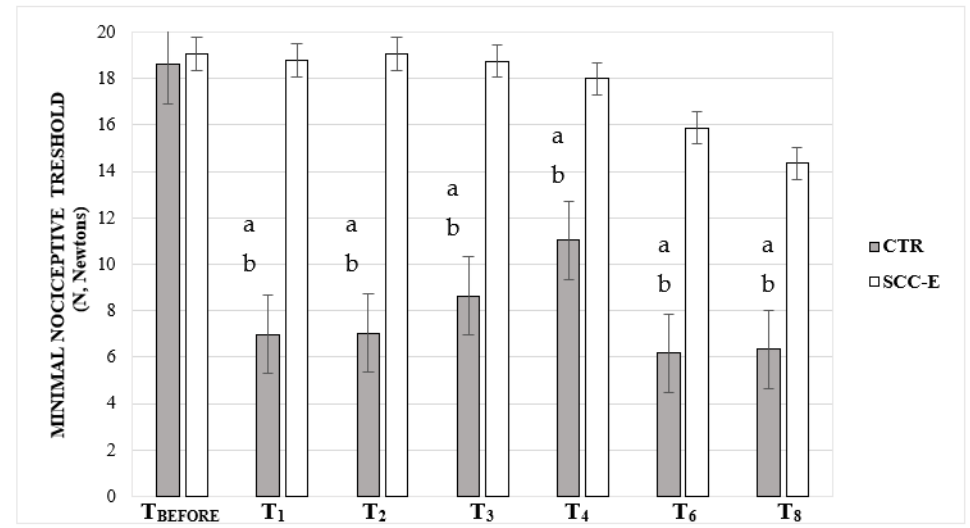
Figure 5. Median and standard deviation of perianesthetic values of mechanical nociceptive thresholds (MNT) in cats undergoing ovariohysterectomy with (SCC-E group) or without (CTR group) sacrococcygeal epidural ( n = 10 in each group). Times: T BEFORE , prior to premedication, T 1 , T 2 , T 3 , T 4 , T 6 , and T 8 = 1 h, 2 h, 3 h, 4 h, 6 h, and 8 h after the end of the surgery, respectively. The horizontal line inside the boxes denotes the median value, while the upper and lower whisker bounds denote the maximum and minimum values. The boxes show the interquartile ranges. a Significant differences compared with T BEFORE ( p = 0.0002, 0.0008, 0.0018, 0.0161, 0.0007, 0.0011 for T 1 , T 2 , T 3 , T 4 , T 6 , and T 8 , respectively). b Significant differences compared with the SCC-E group ( p = 0.0001, 0.0009, 0.0025, 0.0284, 0.0121, 0.0412 for T 1 , T 2 , T 3 , T 4 , T 6 , and T 8 , respectively).